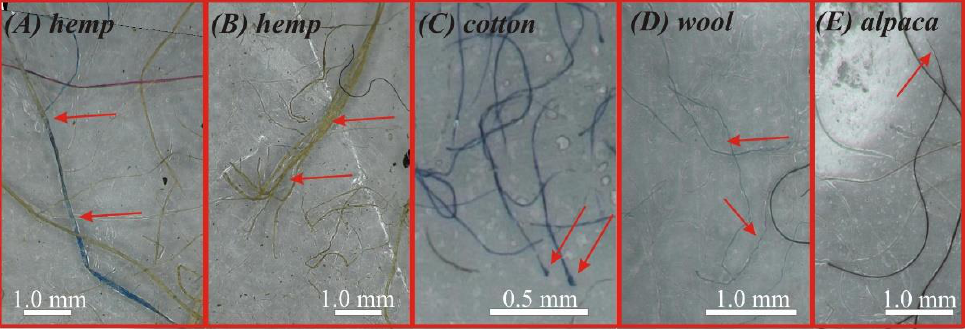
Figure 2. Natural microfibers were excluded from the analysis. ( A ) Hemp fiber with uneven thick- ness and non-uniform dying; ( B ) Ripped hemp fiber with filaments. ( C ) Cotton fibers with uneven thickness and bulbs. ( D ) Wool fiber with uneven thickness. ( E ) Alpaca fiber with thinning